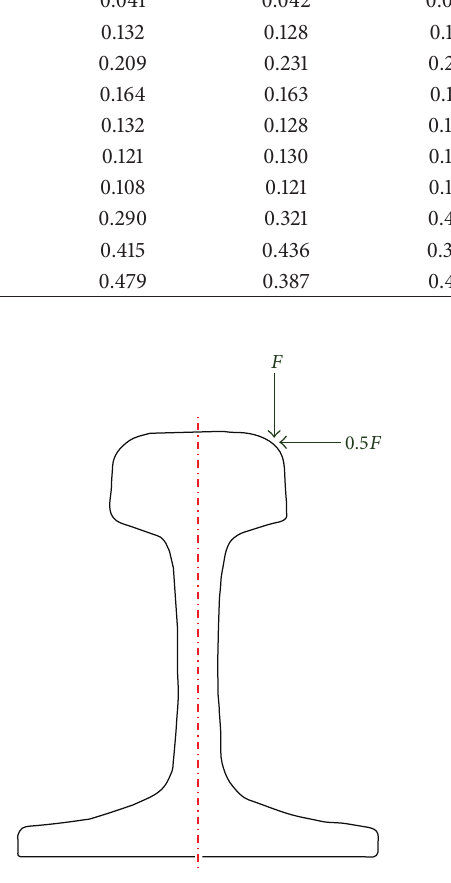
Figure 9: Schematic plot of the forcing